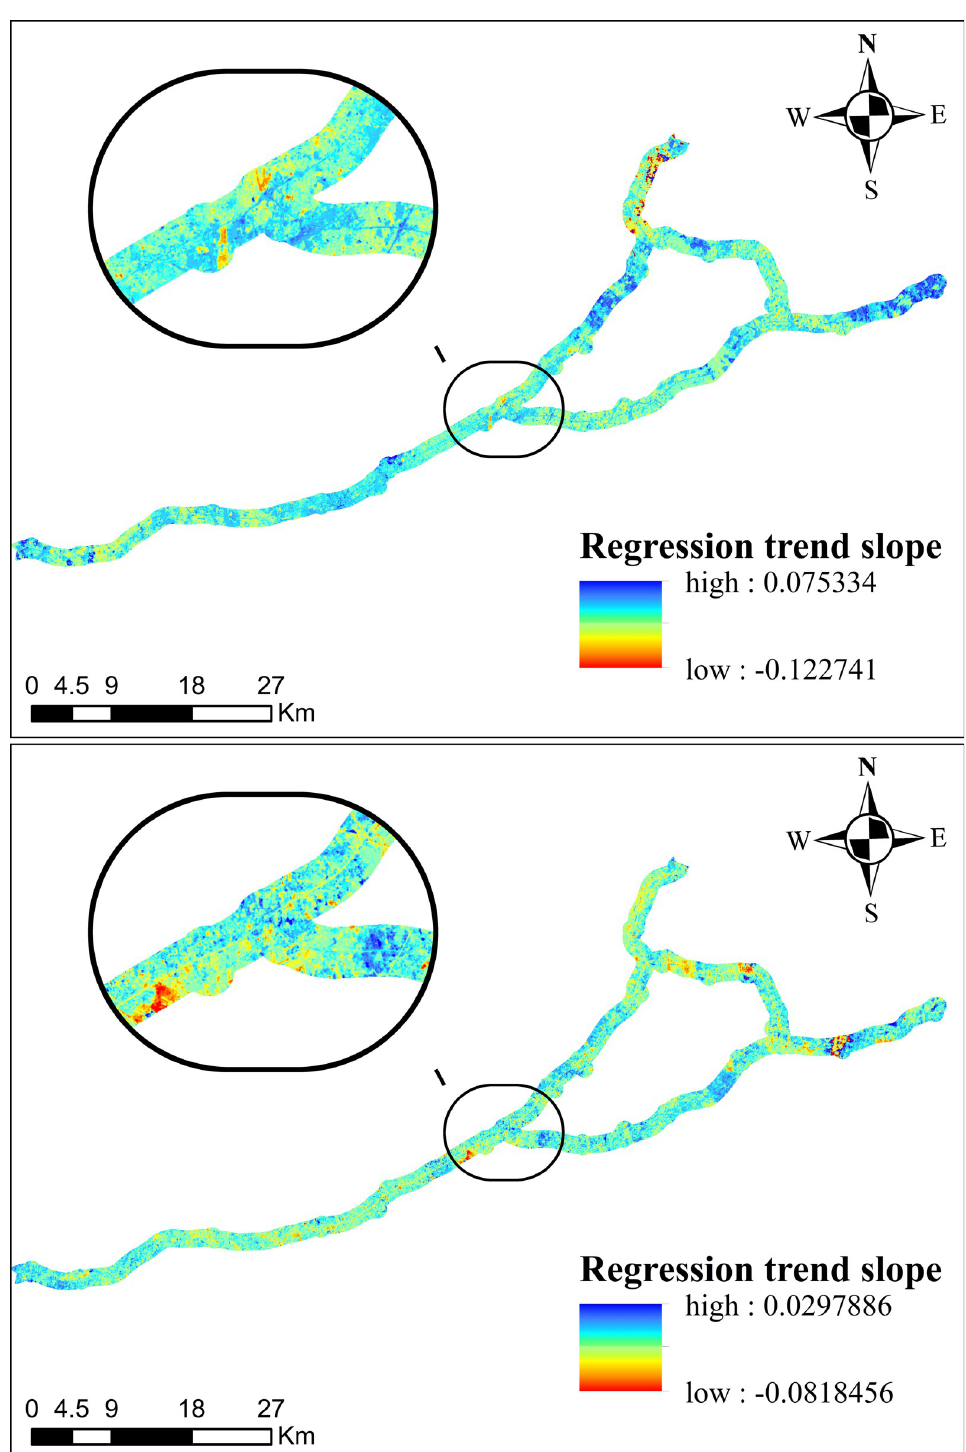
Fig 13. Trend of multi-year VSWI spatial distribution in the buffer zone of Yongjin Expressway. ( a ) Average trend of 2005-2008(during construction) ( b ) Average trend of 2008-2009(finished).